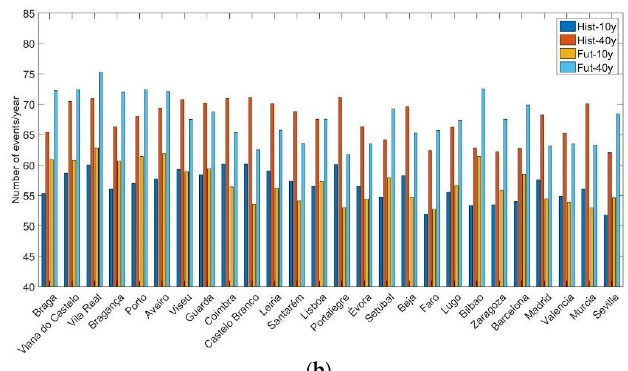
Figure 24. Comparison of the ( a ) event duration (days/year) and ( b ) the number of events (year) in the historical (blue) and future (red) period for extreme events with a return period of 10 years (full line) and 40 years (dashed line) for wind speed at 300 hPa.